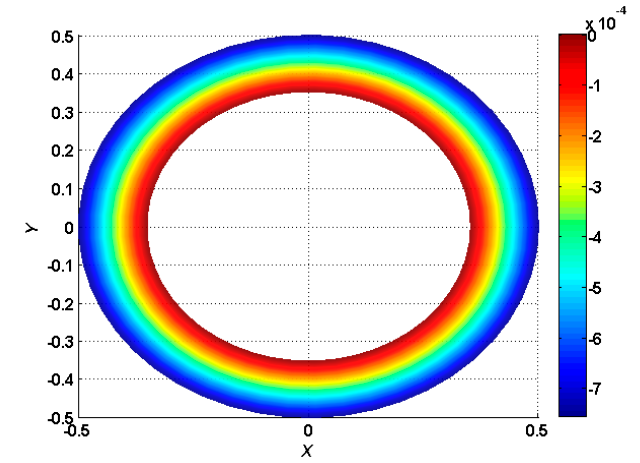
with torus 0.7 h R = and external w wE h q = Al ,